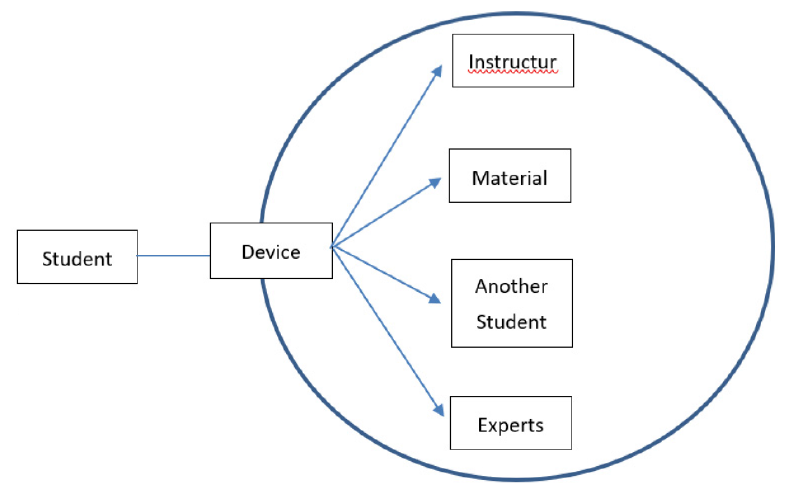
Figure 2. Patterns of interaction in the learning